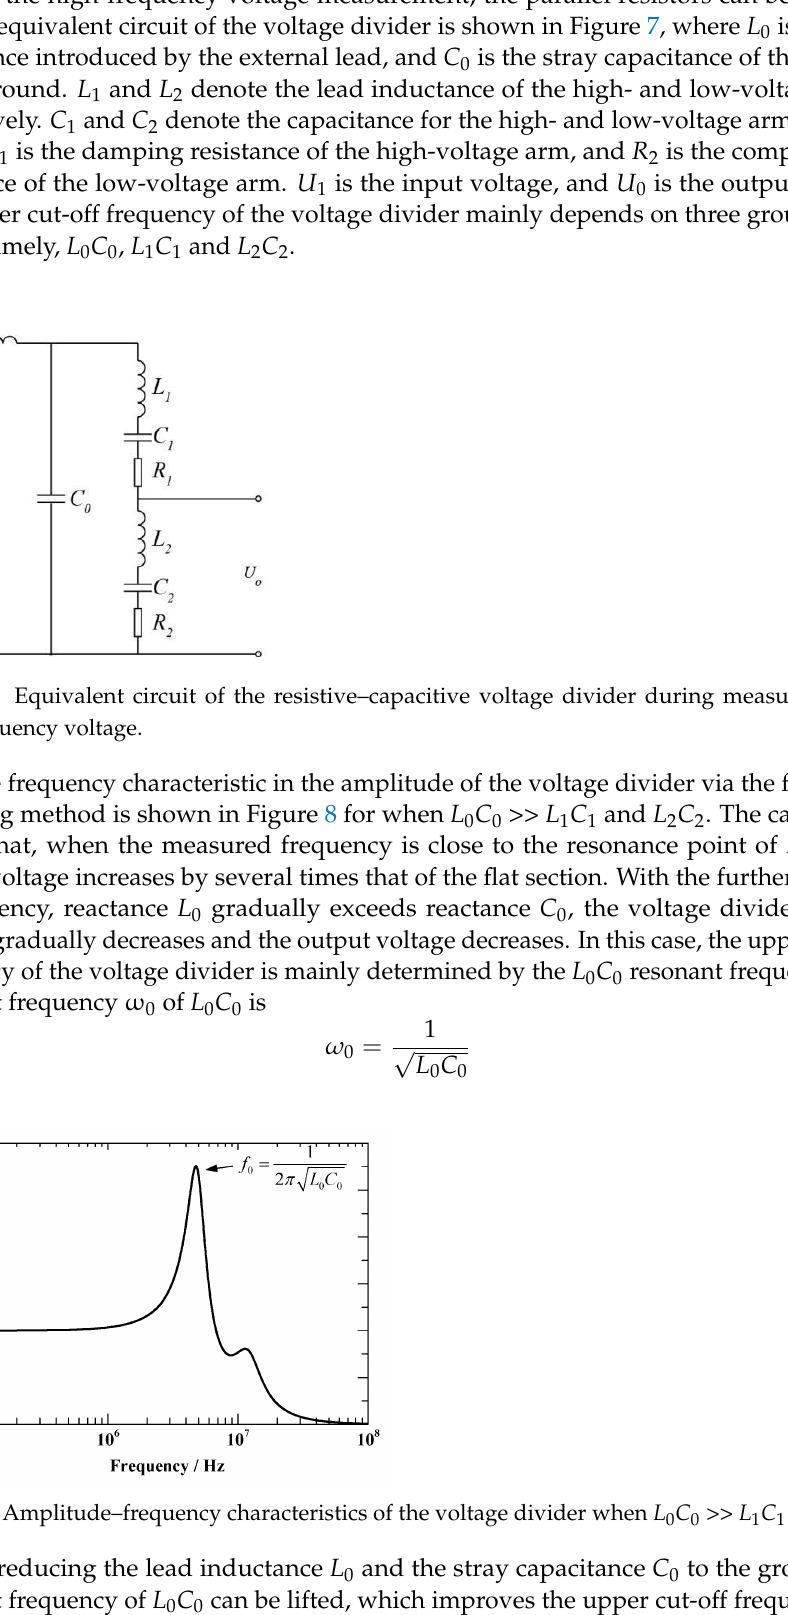
Figure 6. Structure of the low – voltage arm.